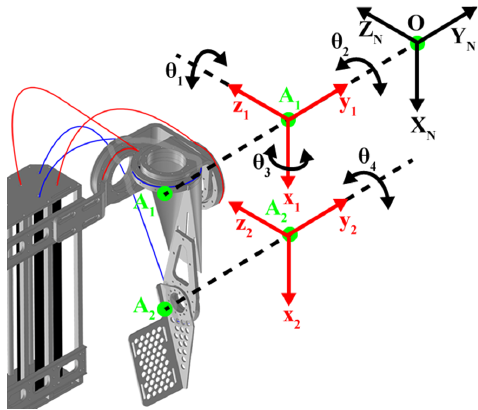
Figure 5. Coordinate systems for dynamic formulation.